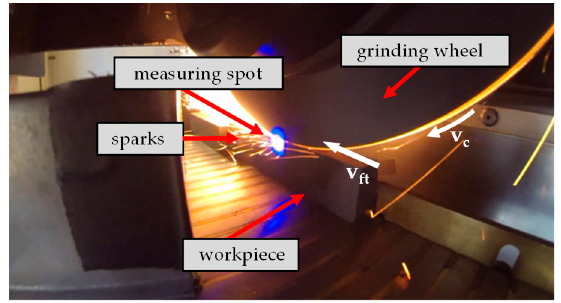
Figure 4. Surface grinding process with flying sparks.